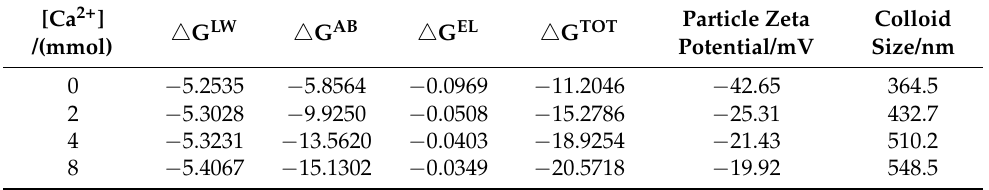
Table 3. Interaction energy, particle zeta potential, and colloid size-indifferent AEM–BSA–Ca 2+ systems.